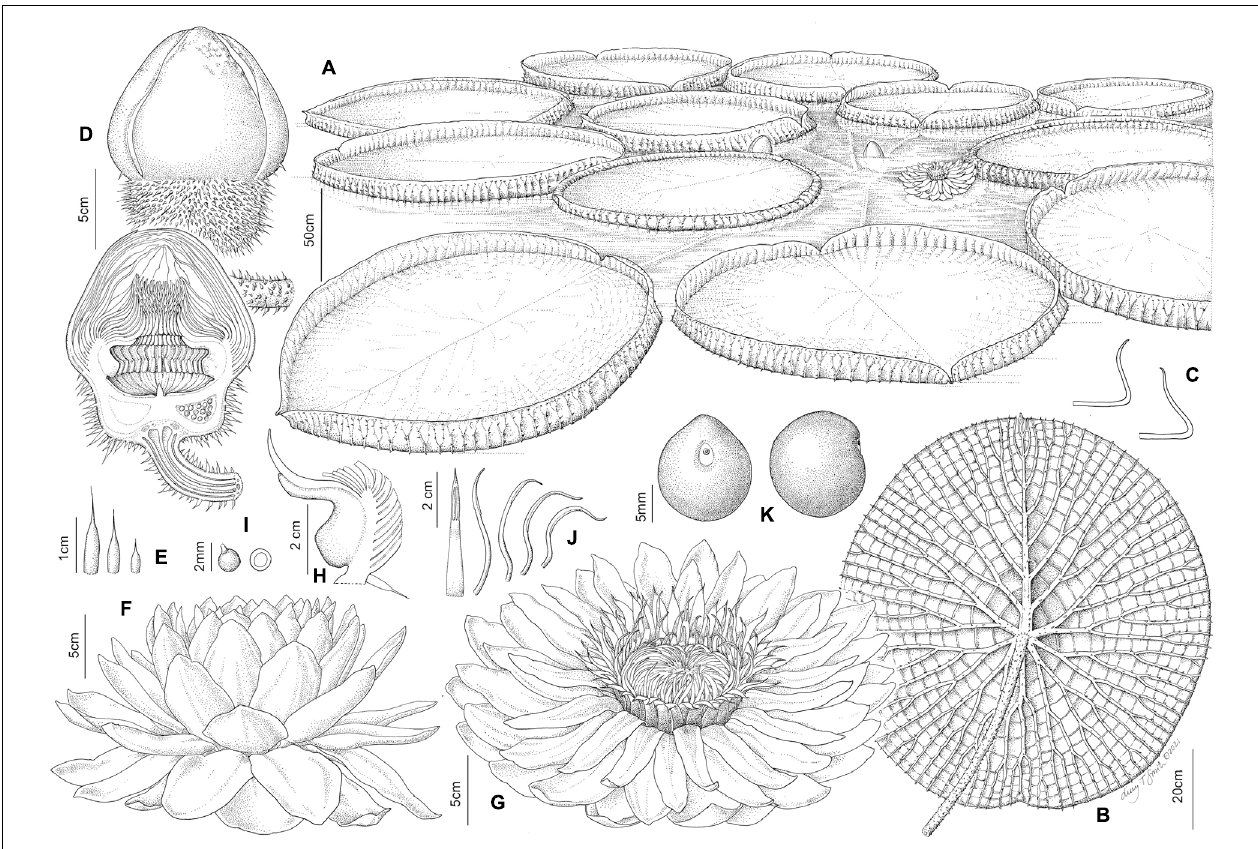
FIGURE 5 | Victoria boliviana sp. nov. (A) habit, (B) abaxial leaf, (C) leaf rim profiles, (D) bud, whole and LS, (E) flower prickles, (F) first night flower, (G) second night flower, (H) carpellary appendages and tepal, staminode attachments; (I) ovule, whole and LS, (J) stamens, (K) seed. (All from material cultivated at RBG Kew). Illustration: Lucy T.